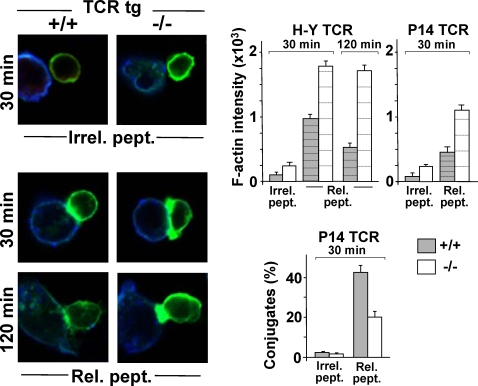
TCR-induced Reorganization of F-actin in Coronin-1A-deficient T Cells.Purified CD8+ LN T cells from conventional TCR tg (+/+) and Coro-1A−/−×TCR tg (−/−) mice were mixed with Cy5-labelled, peptide-pulsed RMA-S cells (blue) (Irr./Rel. pept.: irrelevant or relevant peptide, respectively). At the indicated time, the cells were fixed, permeabilized and stained for F-actin (PhalloidinA-488, green). Representative images from H-Y TCR transgenic mice are shown on the left. The upper graphs indicate mean values of fluorescence intensity at T-cell/APC interfaces for each H-Y or P14 tg mouse model (assessed from the unprocessed images using Zeiss LSM 510 software). Percentages of cell conjugates (as determined by cell counting) using the P14 tg model are shown at the bottom (results from three experiments).